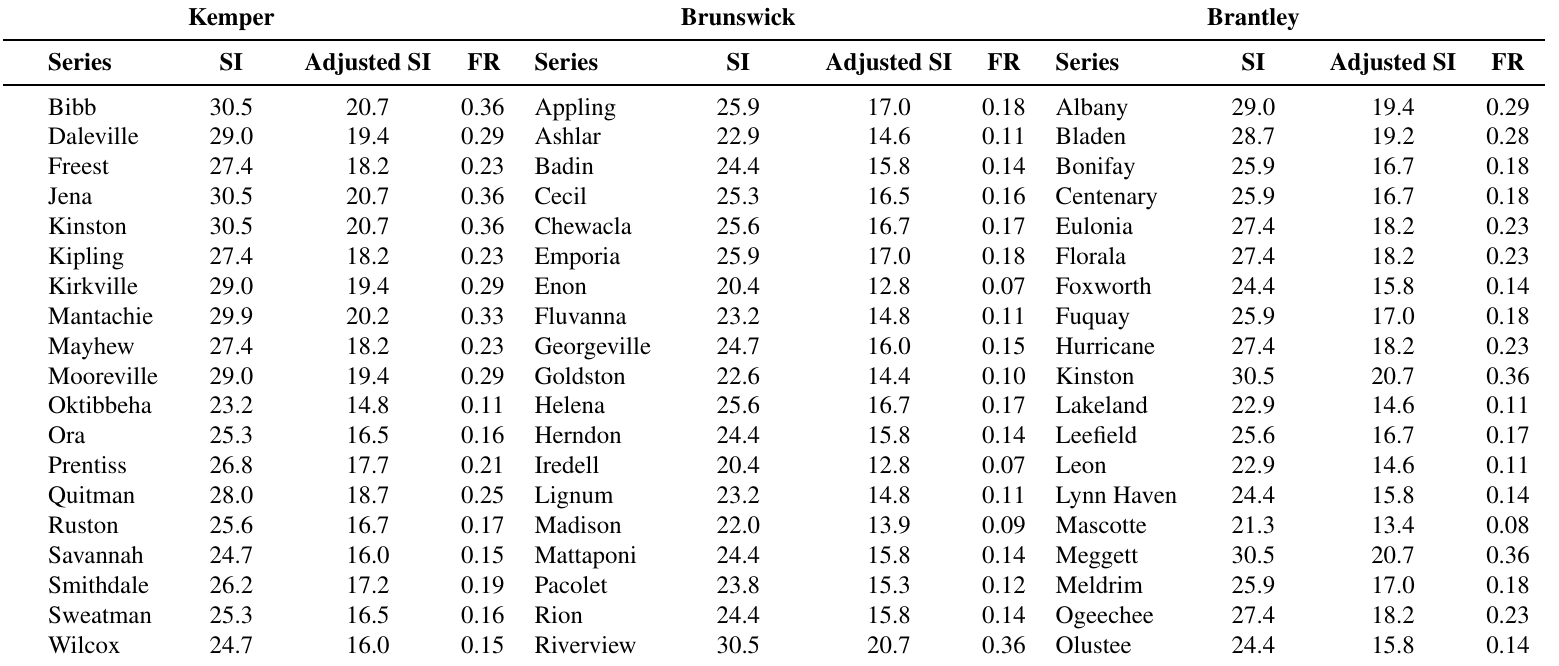
Table 6. Soil series, site index at base age 50, site index adjusted for base age 25 using [41], and FR values derived from site index using Equation (3) in Kemper County, Mississippi; Brunswick County, Virginia; and Brantley County, Georgia based on SSURGO database.